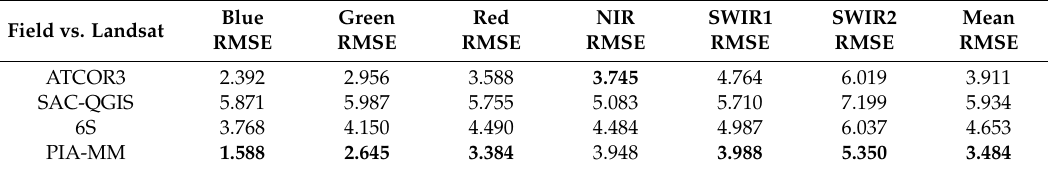
Table 4. Overall band-by-band RMSE between field spectroradiometry values and atmospheric corrections for Landsat (OLI and ETM+) imagery (% reflectance units) grouping all dates. Best values in